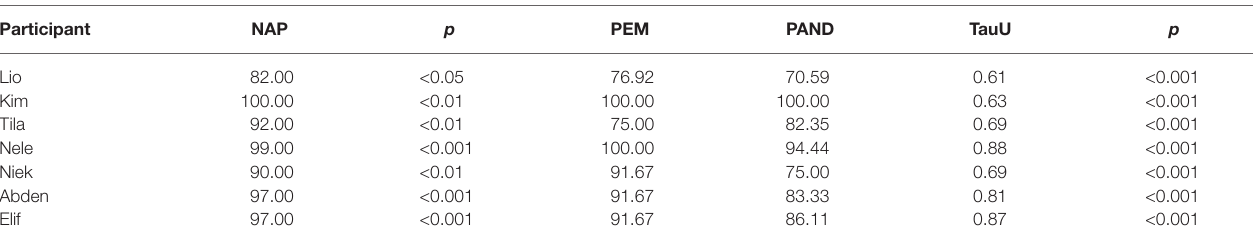
TABLE 9 | Overlap indices for correctly words read correctly.